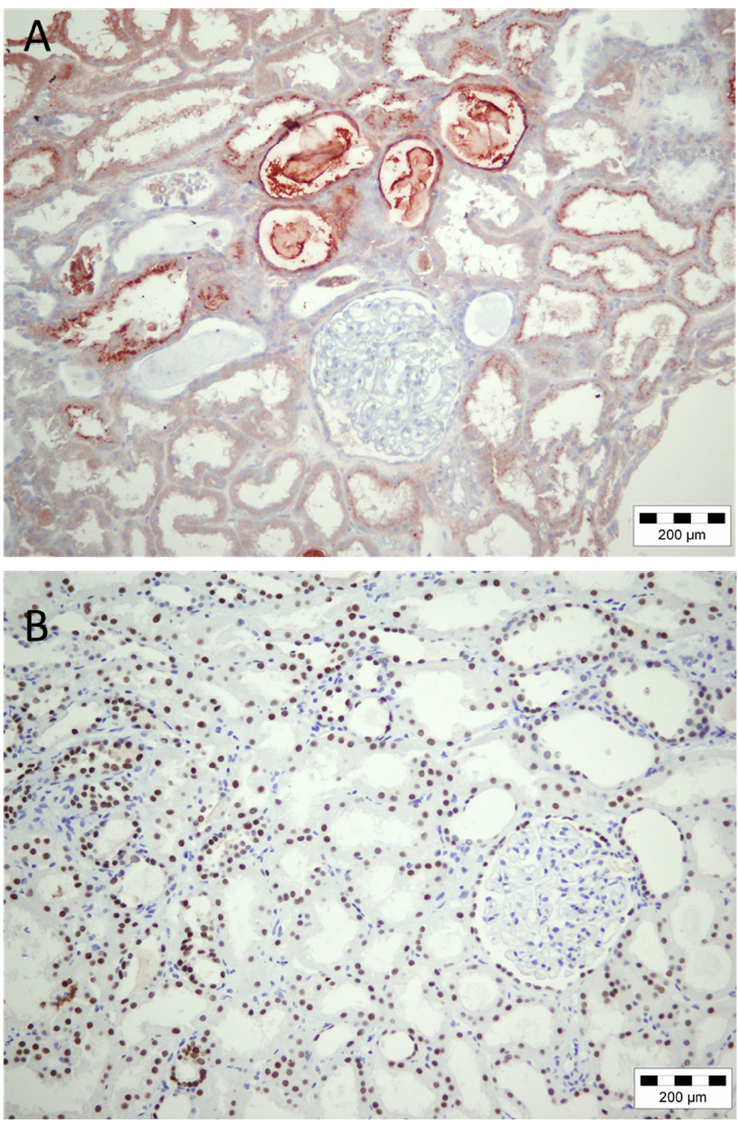
Figure 3. Acute kidney injury due to rhabdomyolysis. ( A ) Immunohistochemical staining with myoglobin revealed positive casts in luminal area of tubuli, as well as presence of myoglobin within some tubular epithelial cells. ( B ) Widespread immunohistochemical expression of PAX8 in myoglobin provoked acute kidney injury.